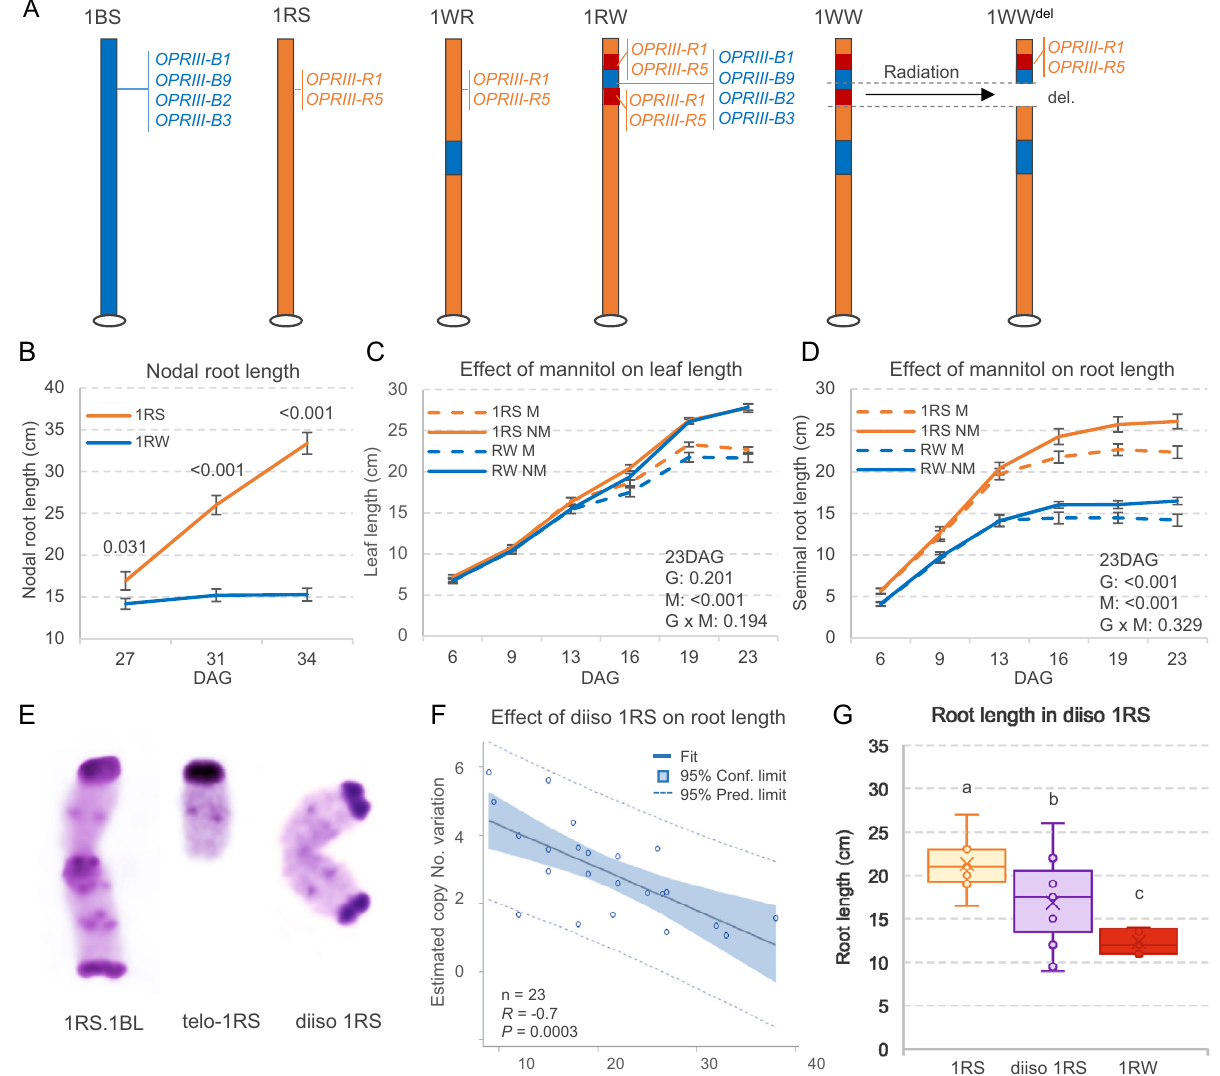
Fig. 1 | Wheat-rye genetic stocks and their effects on seminal root length. A Genetic stocks used in this project. The hexaploid wheat variety Hahn has a complete rye 1RS arm replacing the wheat 1BS arm. Line 1WR has a proximal 1BS segmentintrogressedin1RS,whereas1RWhasadistal1BSintrogression.Line1WW has both wheat introgressions and 1WW del has a 4.9Mb deletion including part of 1BSand1RS.Wheatchromatinisindicatedinblue,ryeinorange,andtheduplicated regioninryeinred.Theeffectof thesestructuralchangeson OPRIII genedosageis presentedasanexample. B Differencesinnodalrootgrowthbetween1RSand1RW ( n =10). Exact P values based on two-tailed t tests at each time point. Effect of mannitolon( C )leafgrowthand( D )seminalrootgrowthin1RSand1RW( n =15 – 18). Exact P values in genotype x mannitol factorialANOVA at23DAG are indicated for G=genotype, M=mannitol, NM = no mannitol, and G x M=interaction. B – D Data